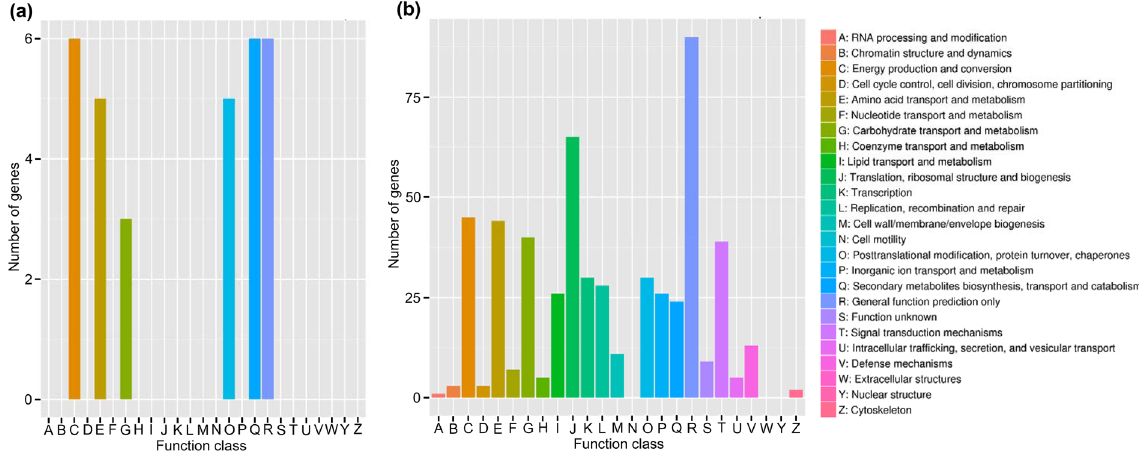
Figure 5. Clusters of Orthologous Groups (COG) function classification of differentially expressed genes (DEGs) of wheat roots ( a ) and Heterodera avenae juveniles ( b ) in the study. The y-axis shows the number of genes in each function class (in different colours on the x-axis).